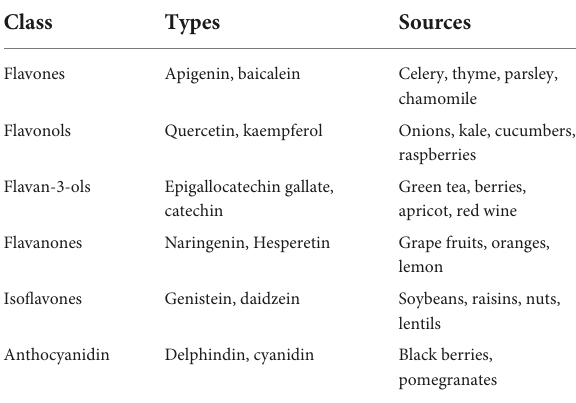
TABLE 1 The major classes of dietary